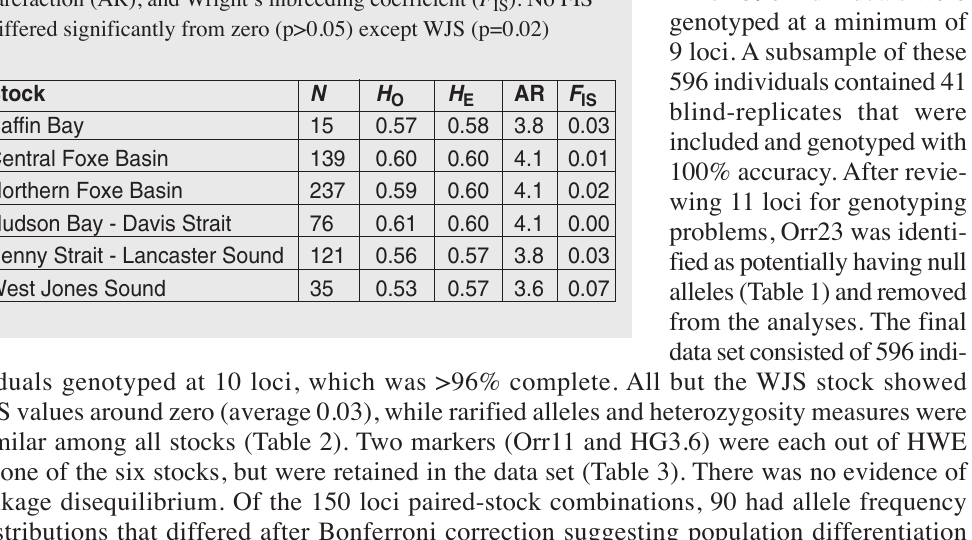
Table 2 . Estimates of genetic variability across Canadian walrus stocks: Number of sampled individuals ( N ), observed heterozygosity ( H O ), expected heterozygosity ( H E ), and allelic richness estimated by rarefaction (AR), and Wright’s inbreeding coefficient ( F IS ). No FIS